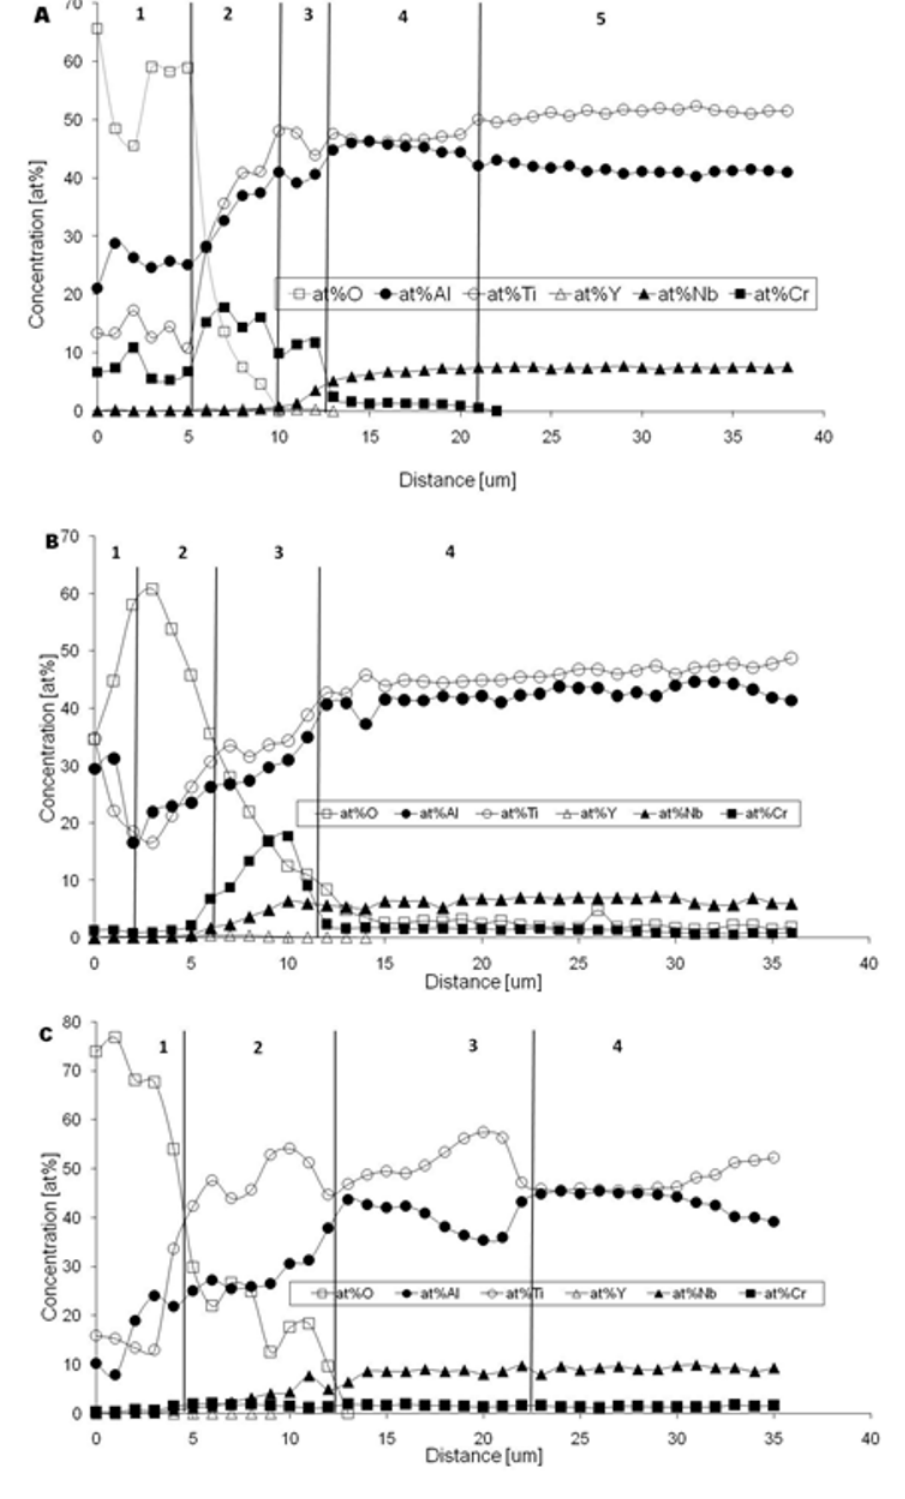
Figure 4. EDS concentration profiles obtained from TiAlCrY coated Ti45Al8Nb alloy after 500 hours of oxidation at A) 750 ◦ C, B) 850 ◦ C, and C) 950 ◦ C